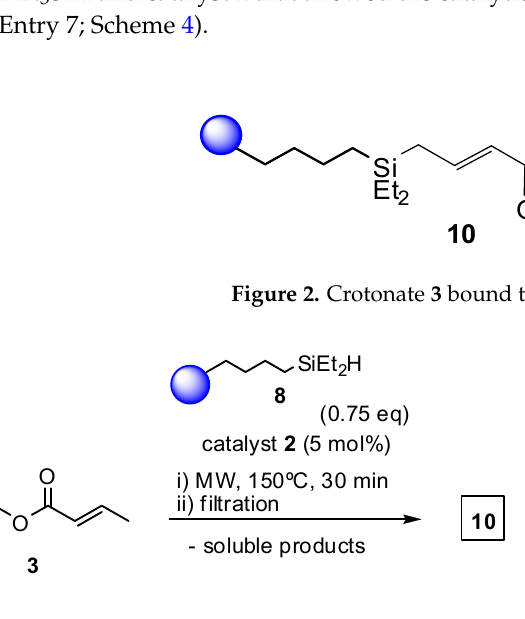
Scheme 4. Generation of the resin ‐ bound crotonate 10 and its further reduction to 4 .